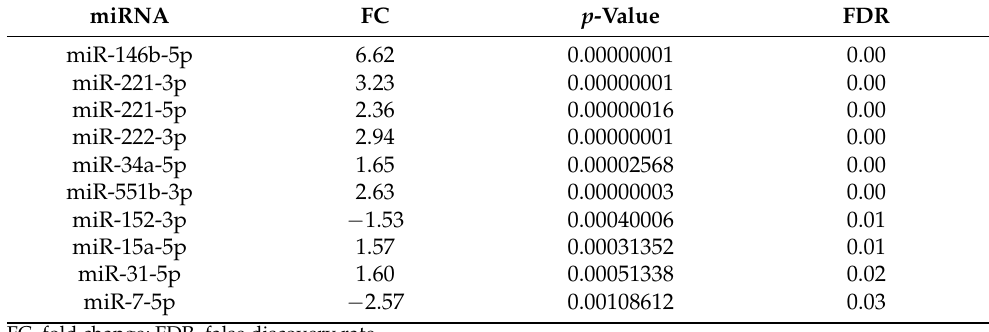
Table 2. miRNAs with significantly different expression between PTC and the control group (FDR < 0.05 and |FC| ≥ 1.5).